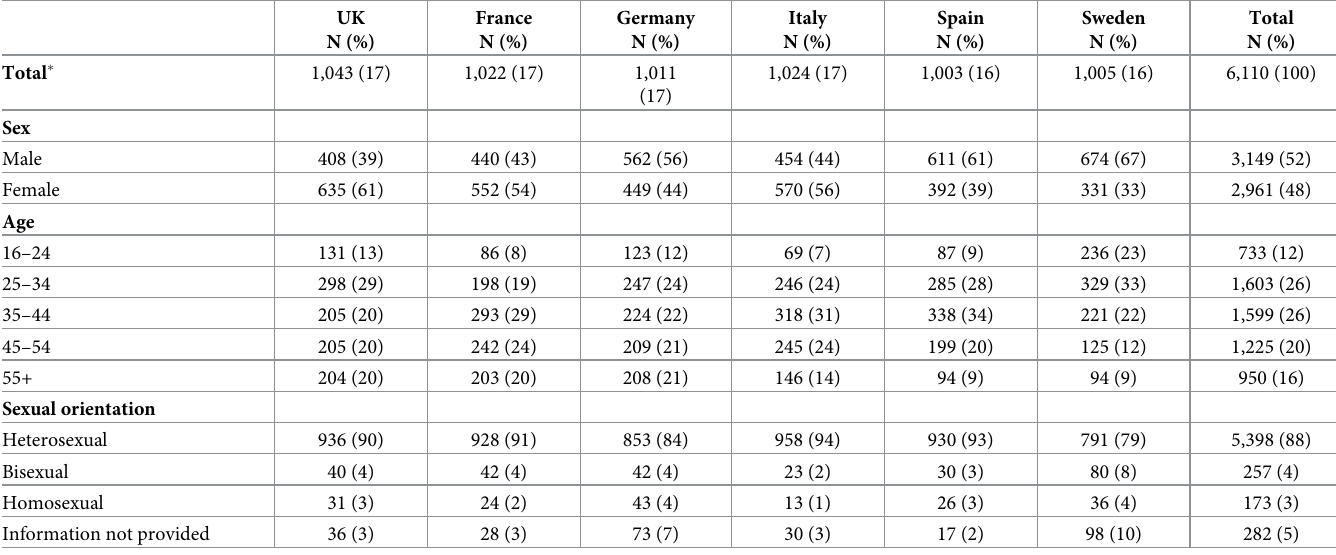
Table 1. Characteristics of study